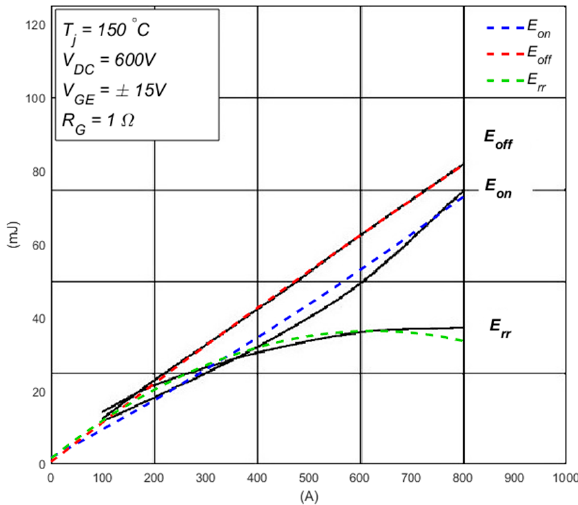
Figure 4. Switching energy losses graphs, comparison between the method SW3 and datasheet.